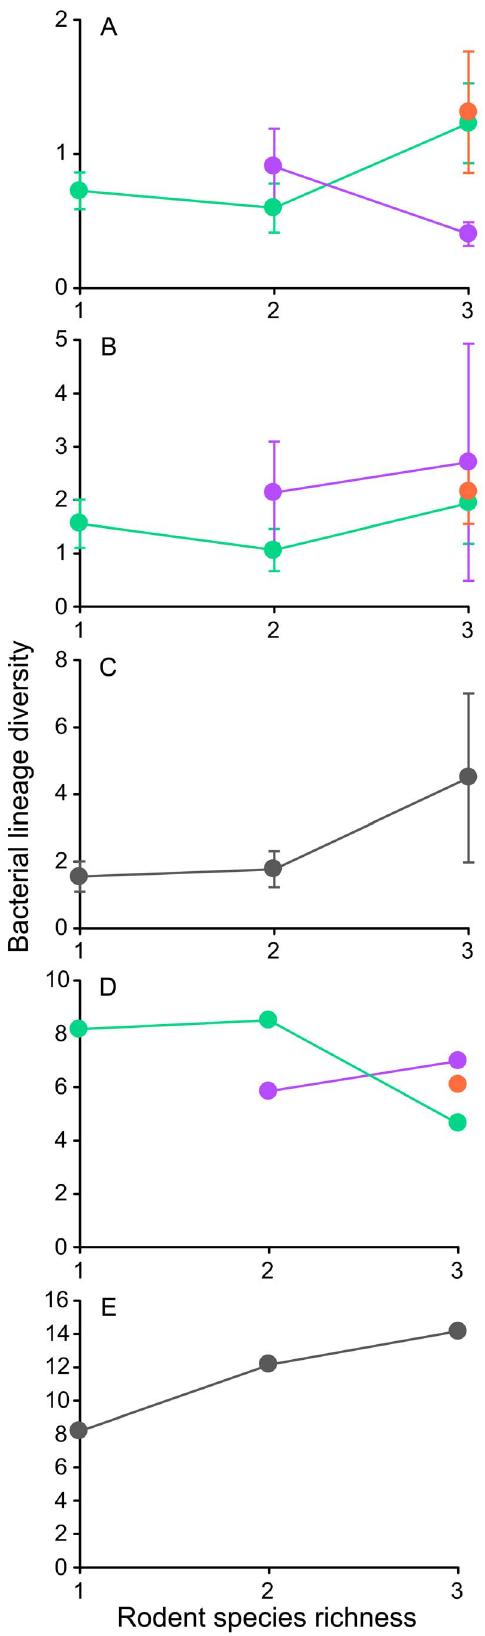
Figure 2. Relationships between bacterial lineage diversity (means ± SE of Fisher alpha) and rodent species richness. Relationships are quantified at different scales and for different organization levels. A- in individual hosts, B- at the plot scale in a population of hosts, C- at the plot scale in a community of hosts, D- at the regional scale in a population of hosts, E- at the regional scale in a community of hosts. The relationships between bacterial diversity and host diversity in individual hosts and host populations are illustrated separately for each host species (G erbillus andersoni is indicated in green, G. pyramidum in purple and G. gerbillus